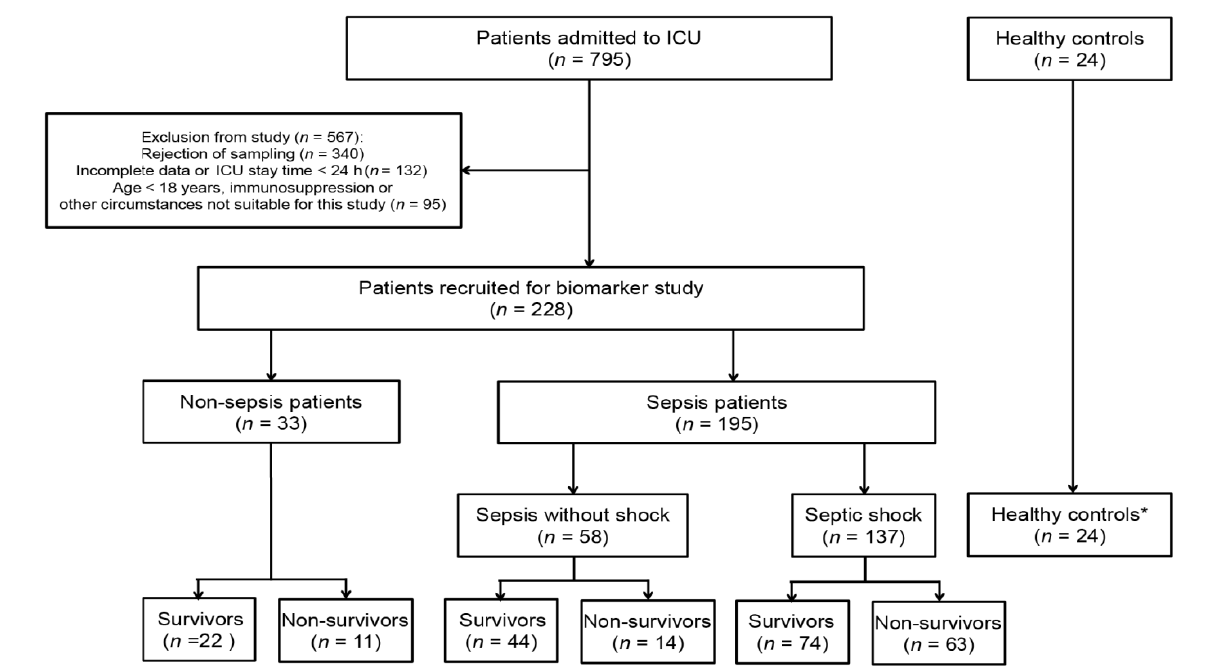
Figure 1. Flow chart of the study population. * Healthy controls were not used for analysis.